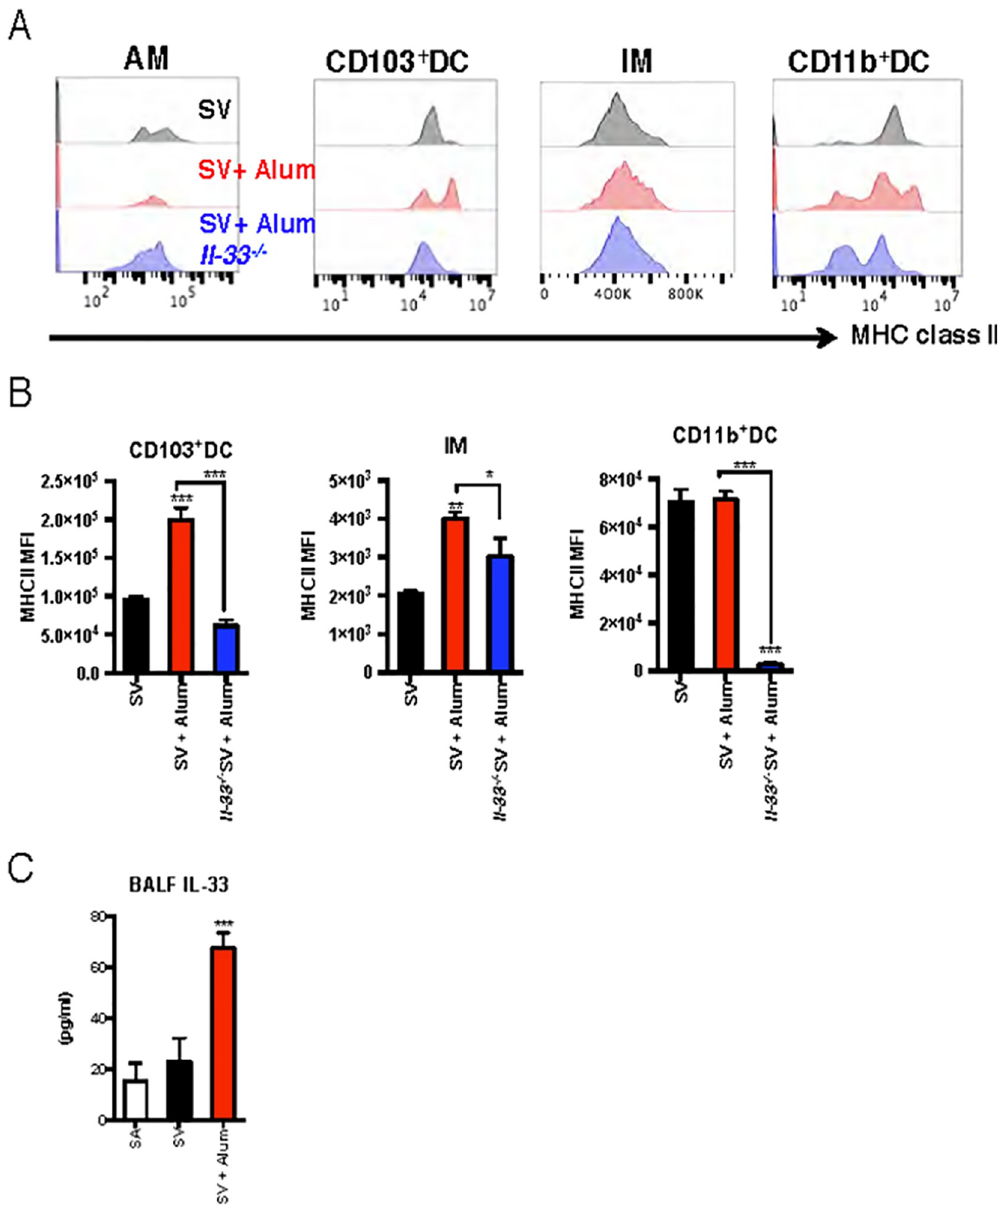
Fig 5. Alum increases MHC class II expression levels of APCs in an IL-33-dependent manner. WT or Il33 -/- mice were intranasally administered SV or SV plus alum. At 24 h after administration, the mice were euthanized, and the lungs or BALF were collected. CD103 + DCs, IMs, and CD11b + DCs in the lung were gated as live (propidium iodide negative) CD45 + SiglecF - CD103 + CD11b mid CD11c + CD11c + CD24 mid , CD45 + SiglecF - CD11c + CD11b + CD24 - , and CD45 + SiglecF - CD11c + CD11b + CD24 + , respectively. Their MHC class II expression levels were individually analyzed ( A ). The median fluorescence intensity (MFI) of MHC class II levels in each cell population was determined ( B ). The IL-33 concentrations in BALF were determined using ELISA (C) . The data are from three independently performed experiments (A–C), and the error bars are presented as the mean ( ± SEM) of three mice per group (A–C). For more than three groups, significance was assessed using one-way ANOVA and Dunnett’s multiple-comparison test to determine differences between SA and other groups. The student’s t -test was used to compare two groups. �� p < 0.01 and ��� p < 0.001 compared with the SV group (B) or SA group (C). � p < 0.05 and ��� p < 0.001.